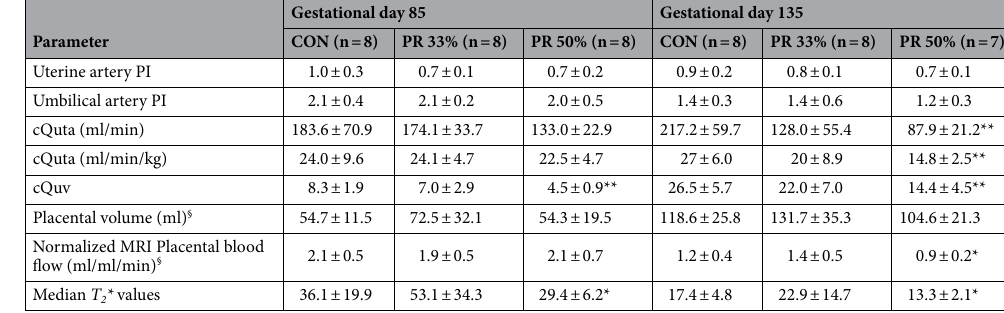
Table 2. Doppler ultrasound and dynamic contrast-enhanced MRI measurements of placental function and oxygenation. § Obtained by DCE-MRI. PI pulsatility index, VT I velocity time integral. CSA (cross section of uterine artery) = π(diameter/2) 2 . Vmean (mean velocity) = 0.5 × maximum umbilical vein velocity. cQuta (uterine artery blood flow) = VTI × CSA × HR. cQuta (ml/min/kg) = cQuta adjusted for maternal weight. cQuv (placental volume blood flow) = Vmean × CSA × 60. One-way ANOVA. Data are means ± SD. *p < 0.05, **p < 0.01.